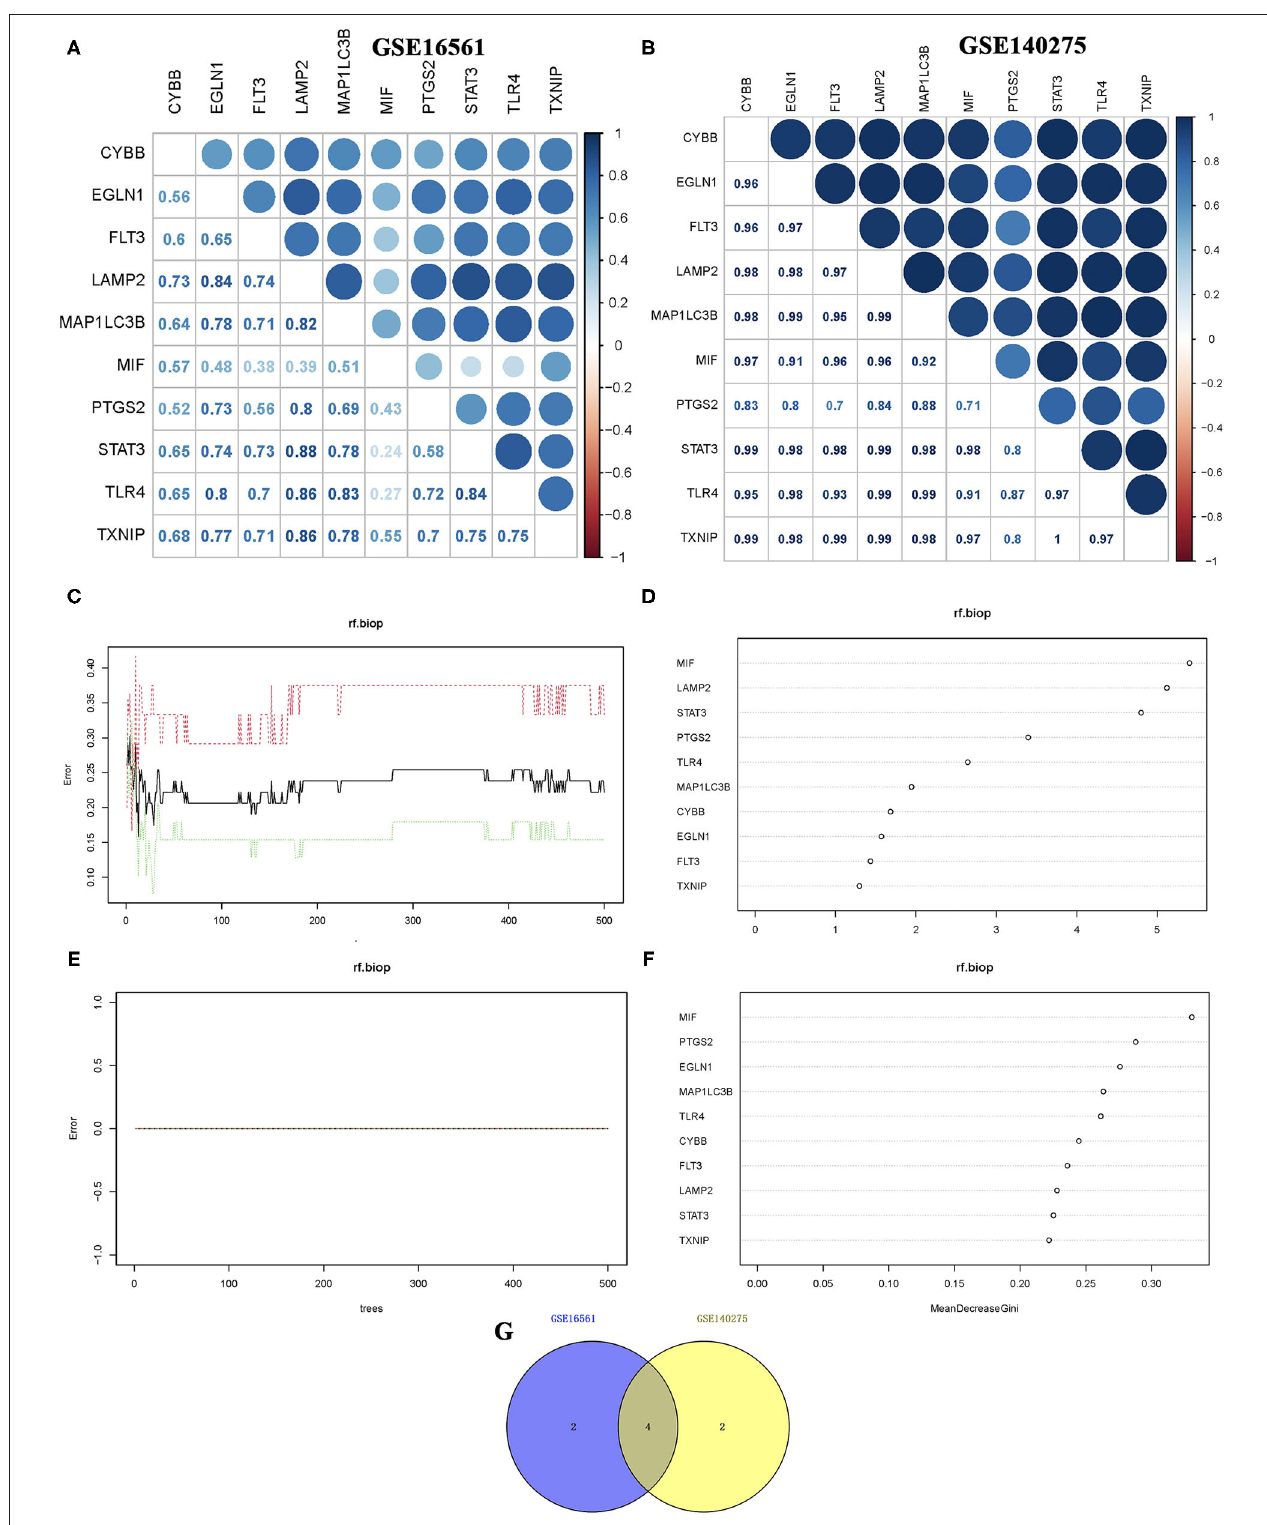
FIGURE 3 | Correlation analysis and random forest screening of candidate ferroptosis-related biomarkers. (A,B) Correlation analysis of candidate ferroptosis-related biomarkers in GSE16561 and GSE140275 datasets. (C,D) Random forest screening of candidate ferroptosis-related biomarkers in the GSE16561 dataset. (E,F) Random forest screening of candidate ferroptosis-related biomarkers in the GSE140275 dataset. (G) Venn diagram revealed the ferroptosis-related biomarkers screening random forest analysis in GSE16561 and GSE140275 datasets.